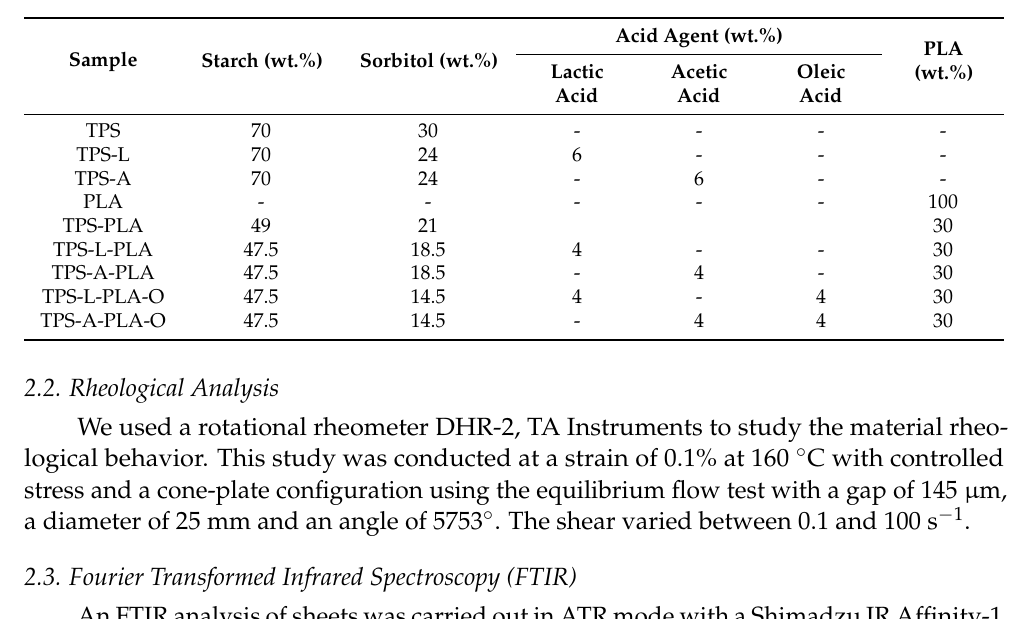
Table 1. Proportions of starch, plasticizing, acid agent and poly(lactic acid) (PLA) used for the preparation of the thermoplastic starch. TPS: thermoplastic